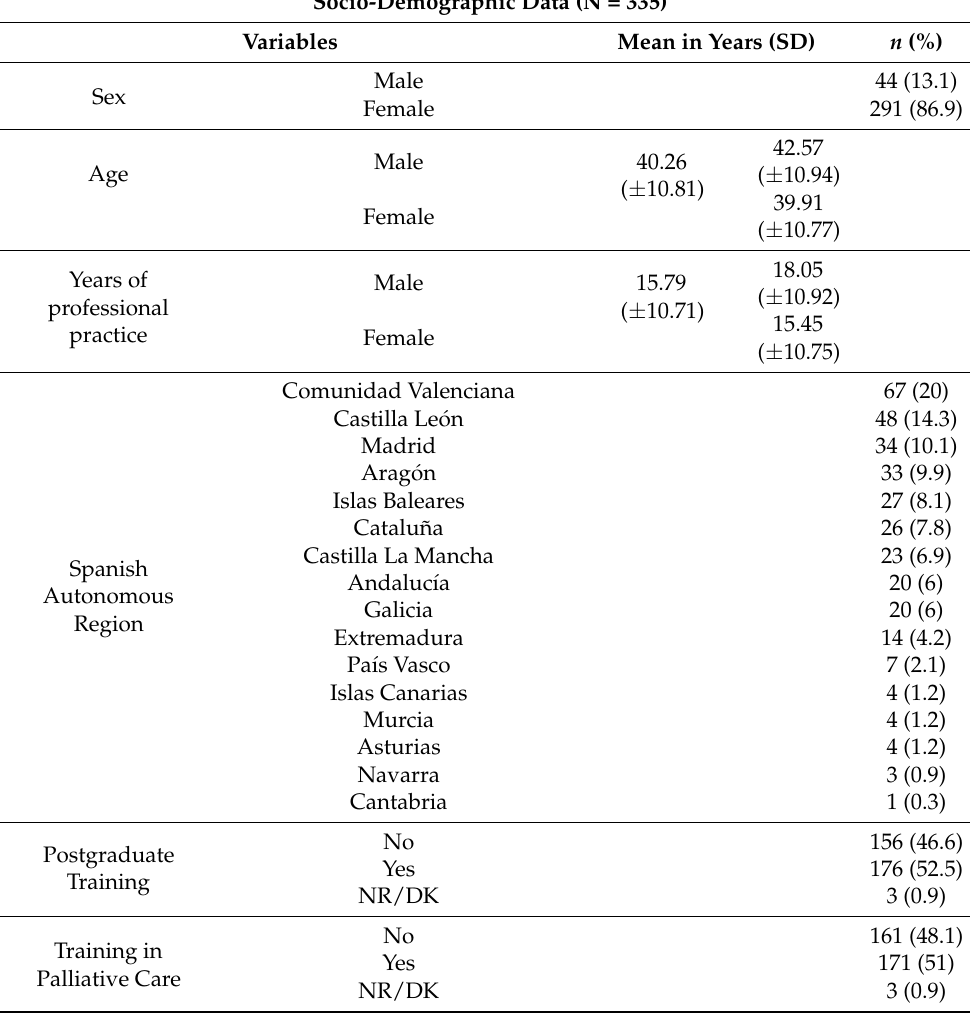
Table 1. Socio-demographic data of the